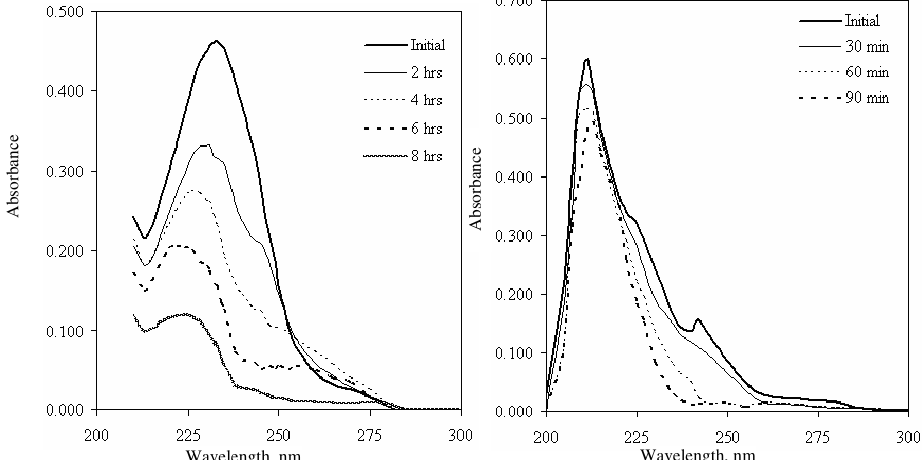
Figure 2d. Spectrum changes of 2,3-DCBA with time 2,3-DCBA = 4.0 x 10 -5 M, [2- Naphthol] = 5.0 x 10 -5 M, light intensity= 11.8 x 10 -8 E sec -1 , pH =11.5,Temperature = 298